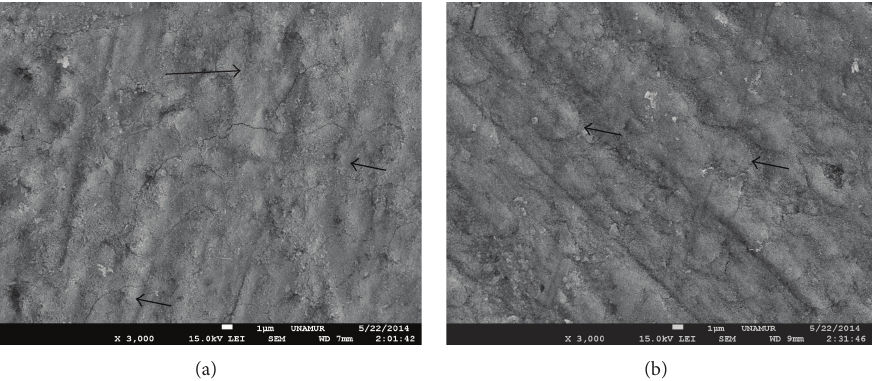
Figure 4: SEM view of Nd:YAP lased dentin treated previously with EDTA (18%). SEM view of exposed dentine with Nd:YAP laser beam at 2 W (a) and 3W (b). We notice a total occlusion of tubules. Arrows show some total occluded tubules. Magnification: